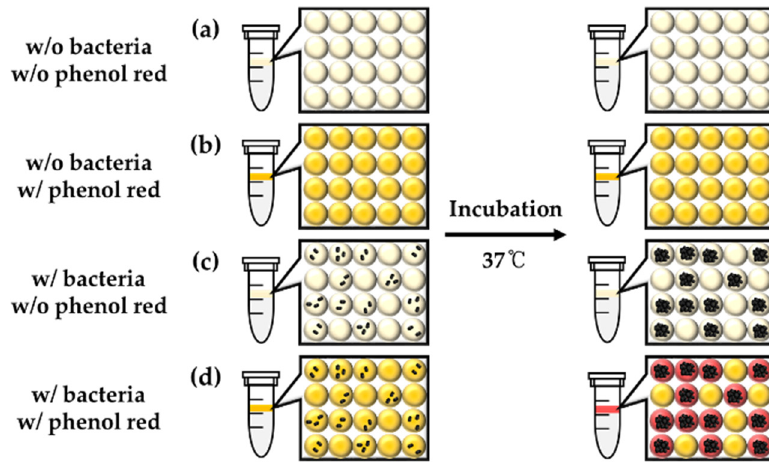
Figure 6. Schematic diagram of the experimental plan to determine bacterial growth by cultivation within droplets using s pH indicator. ( a ) Empty droplets, ( b ) phenol red droplets, ( c ) bacteria droplets, ( d ) phenol red and bacteria droplets for the incubation and detection by the color change of phenol red.